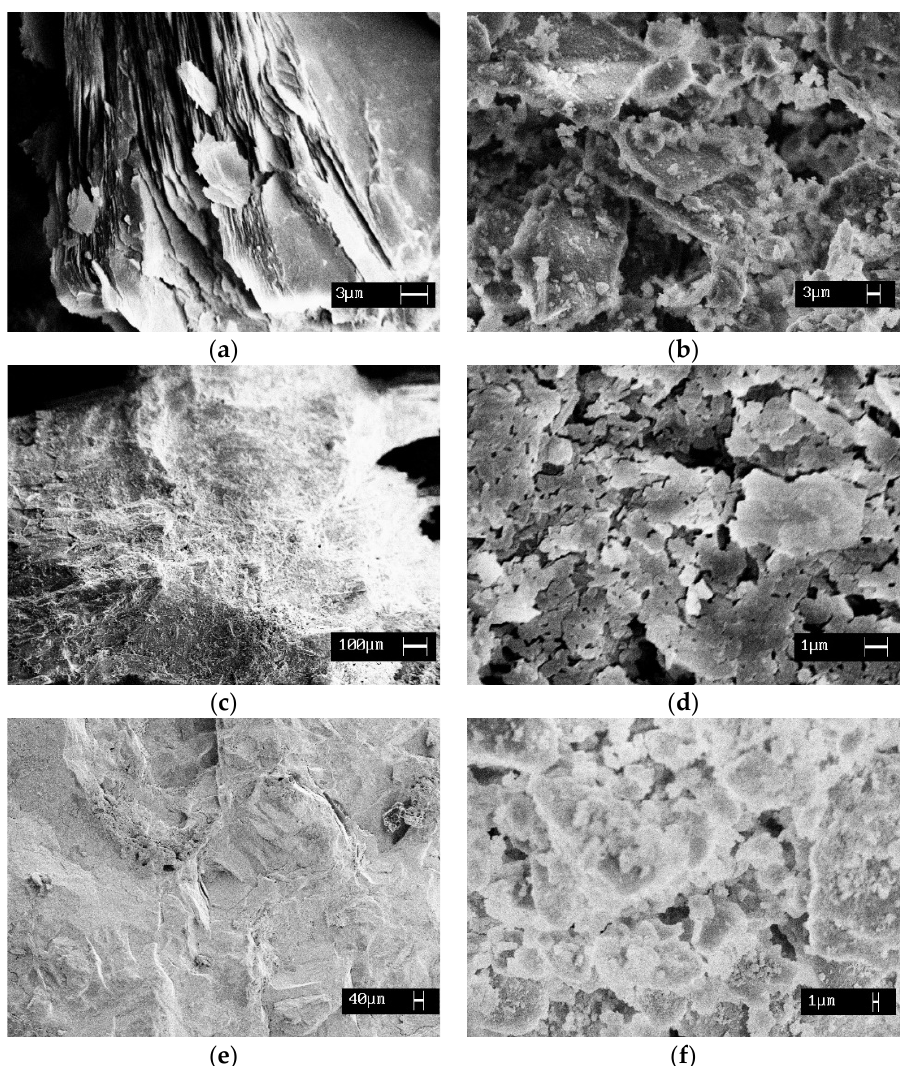
Figure 4. Surface texture of the initial serpentines SLH ( a ), SAP ( c ), SCH ( e ), and binder materials from hydrated heat ‐ treated serpentines SLH ( b ), SAP ( d ), SCH ( f ).